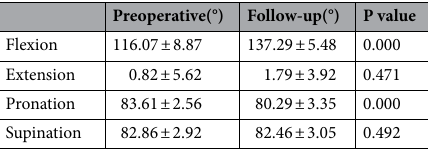
Table 2. Comparison of ROM (preoperative vs follow-up) in patients. ROM range of motion.